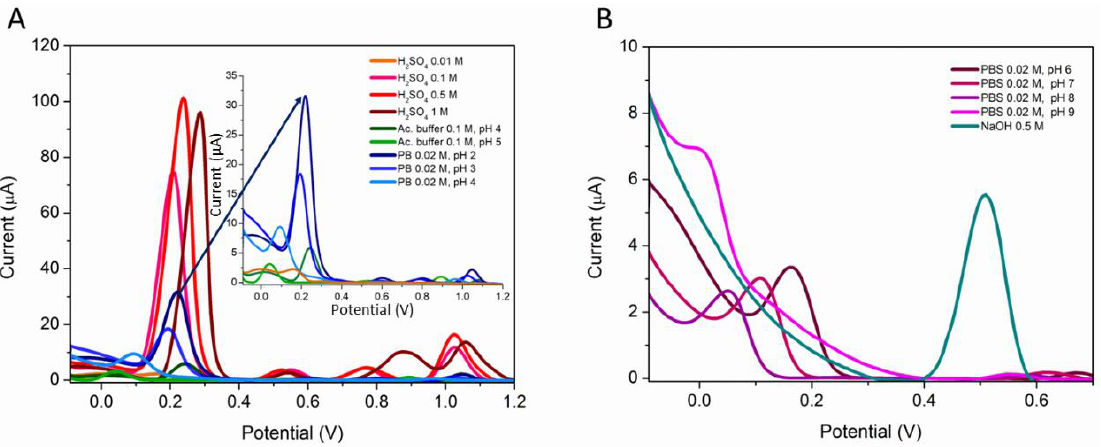
Figure 3. DPV analysis on CNT-SPE of 50 µ M PQS prepared in different electrolytes: ( A ) acidic pH and ( B ) neutral and alkaline pH.